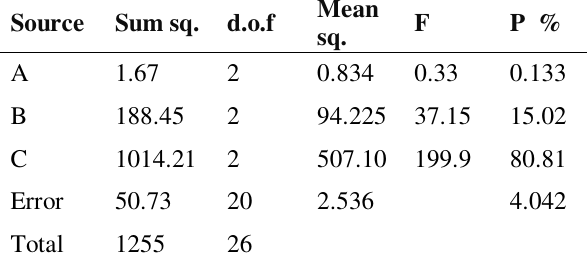
ANOVA result Source Sum